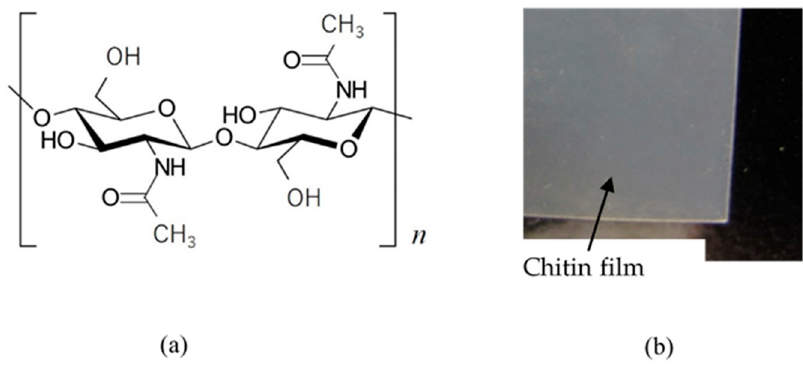
Figure 1. Molecular formula of chitin ( a ) and photograph of chitin film( b